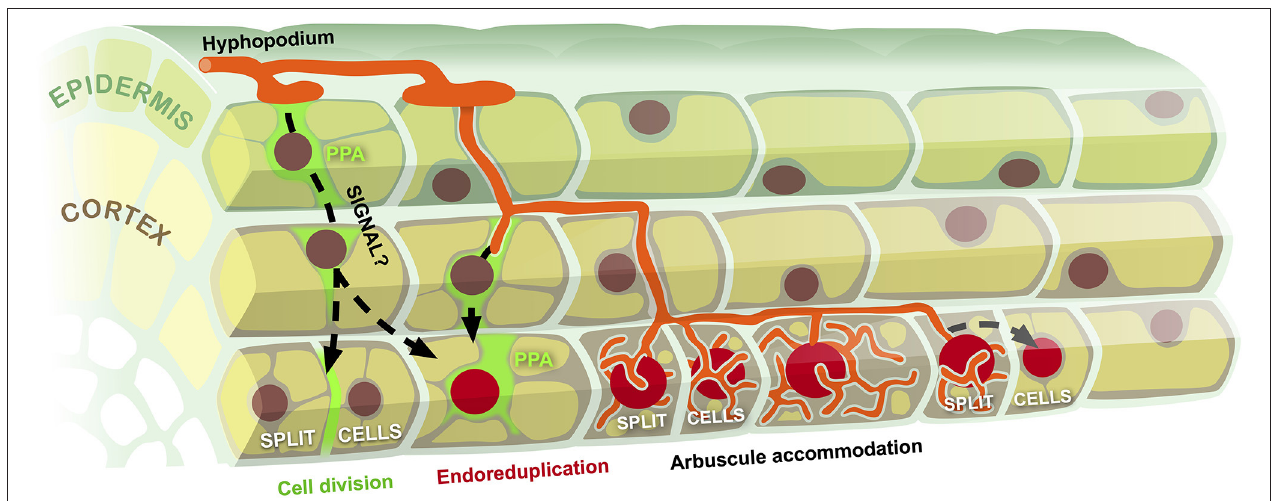
FIGURE 1 | Model of cell cycle reactivation during fungal accommodation in AM. Hyphal colonization of the root epidermis associated with prepenetration apparatus assembly (PPA) triggers a so far uncharacterized signaling process (black dashed arrows) targeting inner cortical cells. This causes the reactivation of cell cycle processes, leading to occasional cell divisions (split cells) and diffuse events of endoreduplication (large red nuclei). Progressive intraradical development of the symbiotic fungus reiterates the stimulation of cell cycle activation, leading to multiple rounds of endoreduplication in advance of arbuscule accommodation and to the expansion of the endoreduplication zone at the front of the developing colonization unit.